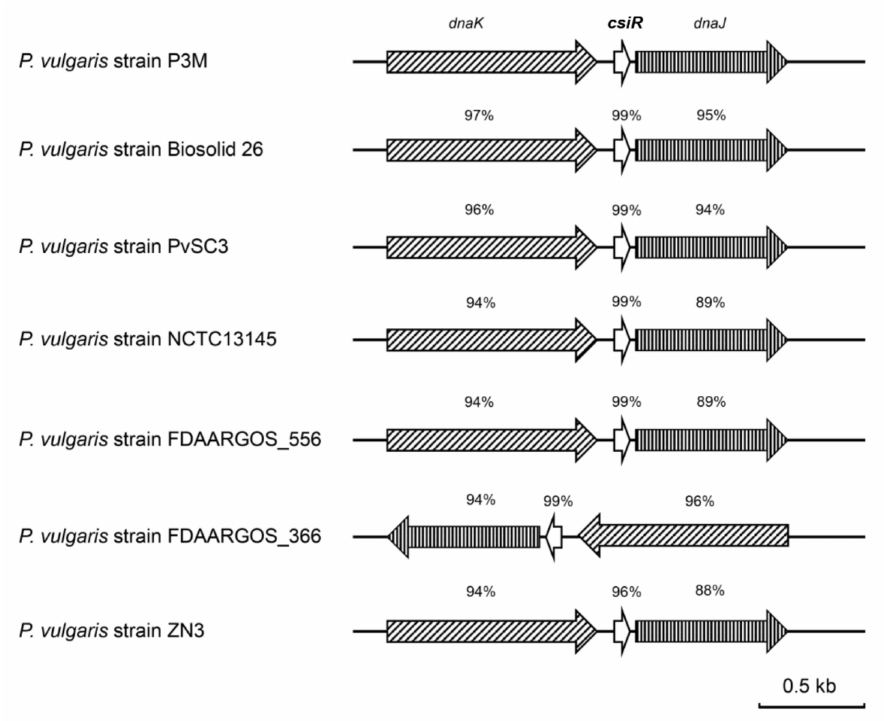
Figure 9. Sequence alignment analysis of csiR in all sequenced P. vulgaris strains.